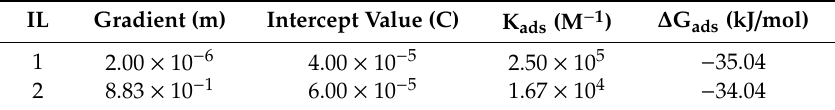
Table 3. Results of the adsorption mechanism determination of IL1 and IL2 following the Langmuir isotherm model.